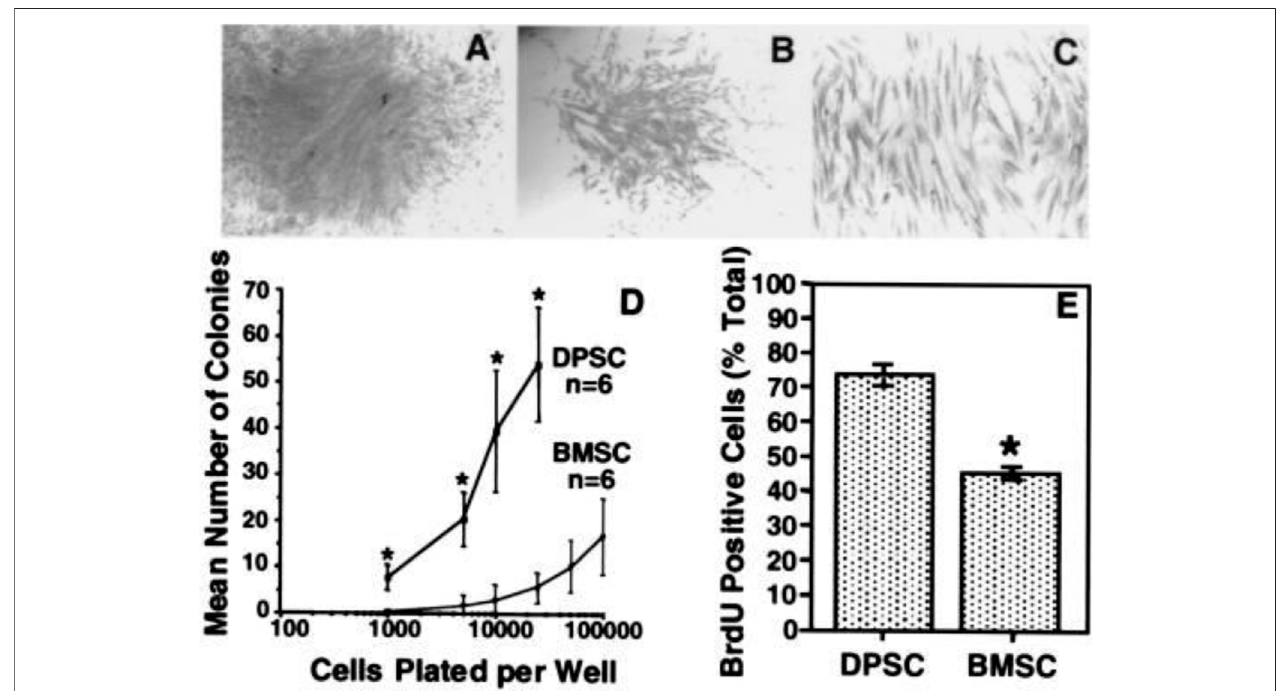
FIGURE1 | In vitro colony formationef fi ciency and cell proliferation. After14 days, representative colonies witha high (A) and alow (B) density. Theappearance is characteristic of fi broblast-like cells (C) . The frequency of colony-forming cells in the dental pulp tissue and bone marrow at numerous plating densities suggests that dental pulp has agreater number ofclonogenic cells than bone marrow (D) . BrdUrd-positive cells were represented asa proportion ofDPSCs and BMSCsenumerated (Gronthos et al., 2000).